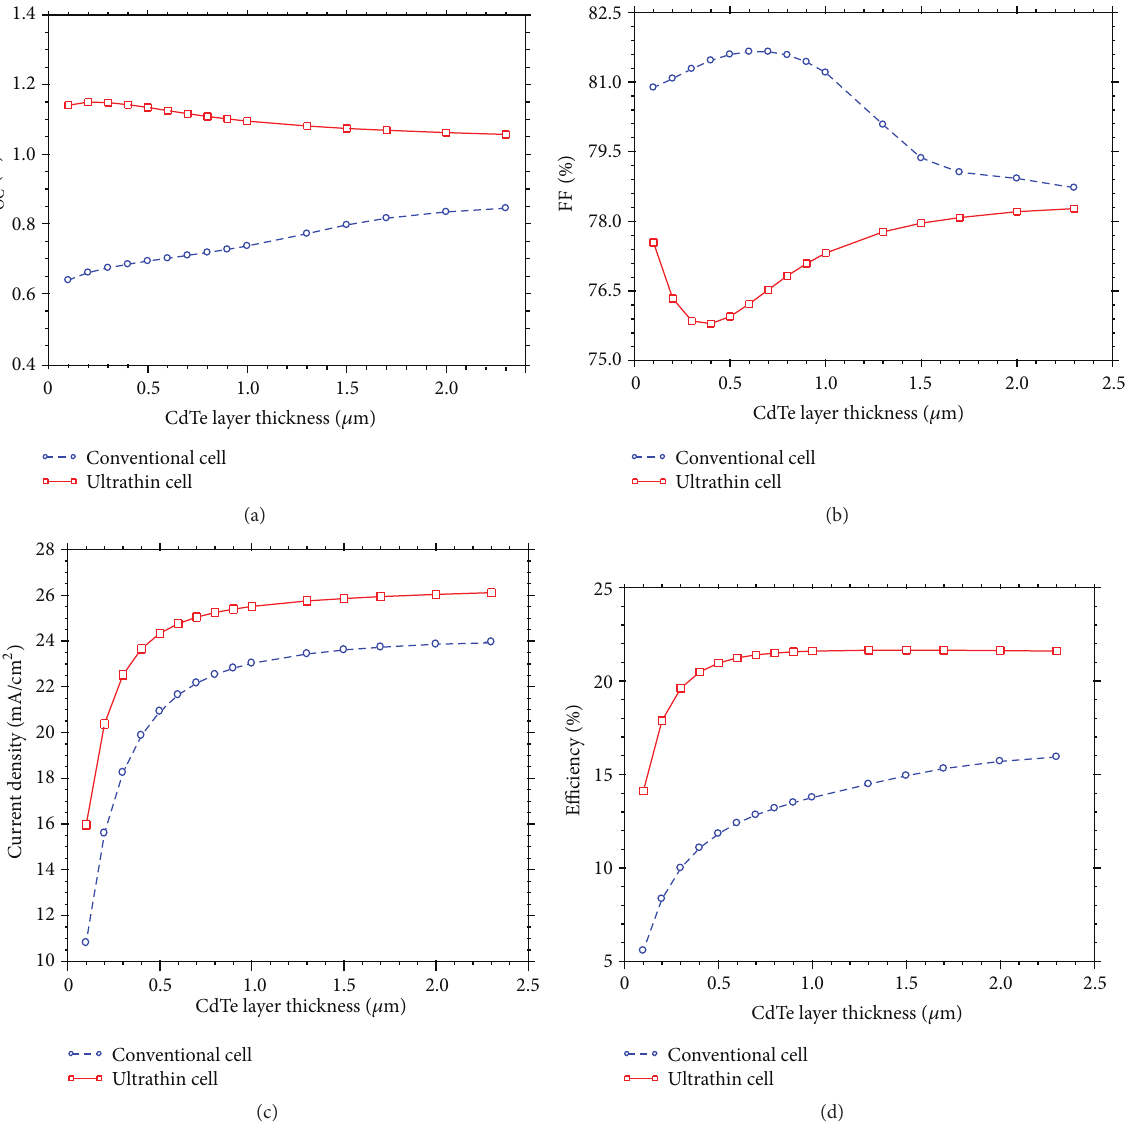
Figure 7: Comparison of electrical parameters ( 𝑉 OC , FF, 𝐽 sc , and efficiency) of ultrathin structure and conventional solar cell as a function of CdTe absorber